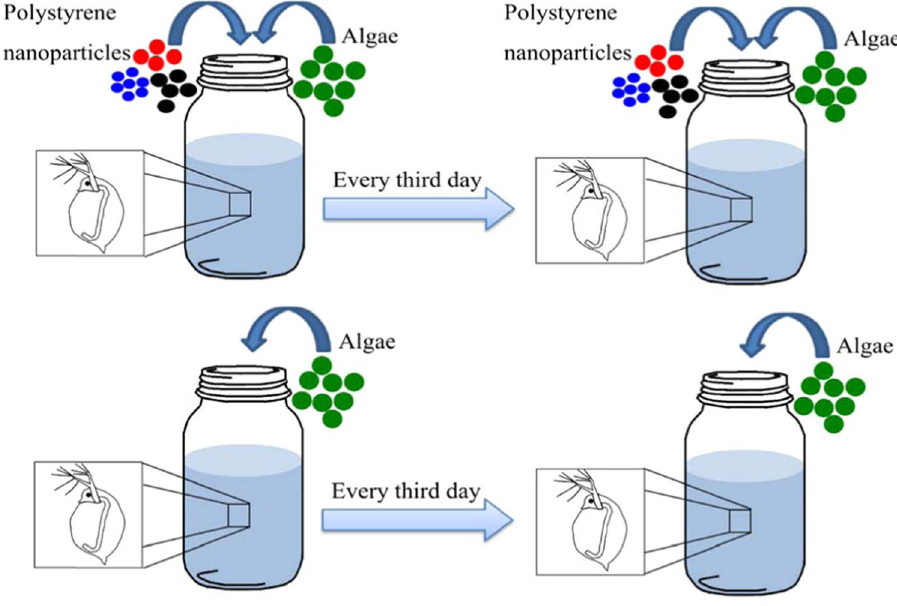
Figure 1. Schematic representation of long-term toxicity test. In total, there were ten replicates in each treatment. During the exposure to polystyrene nanoparticles, alive Daphnia magna individuals were transferred every third day to 100 mL glass beakers with 80 mL total volume of fresh medium, containing 2.5 mL of food (algae), with (treatment) or without (control) particles. Nanoparticles were dialyzed prior the experiments and particle sizes were measured during exposure using DLS. Algae concentration and water pH values were measured every time D. magna was